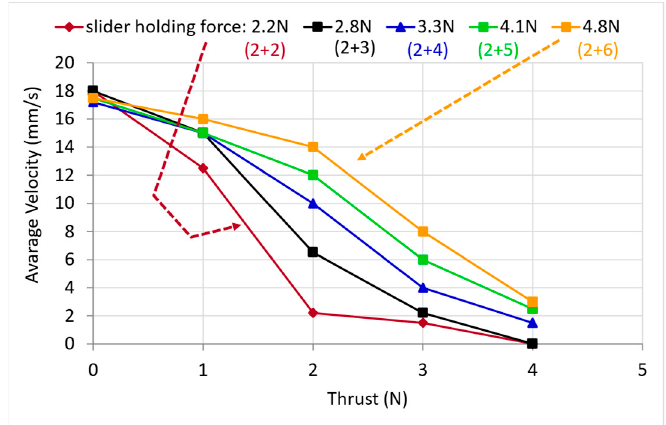
Figure 22. Load characteristics and effect of additional sheet metal flat springs at the back of the stator. Each additional spring increased the holding force by approximately 0.5 to 0.7 N.